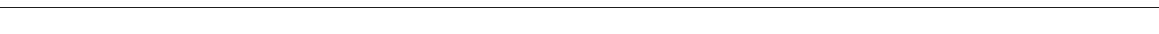
Fig. 5 The role of the Twist1-Prrx1-TNC PFL as a bistable switch was validated using an in vitro fi broblast line, cutaneous wound healing, and patient- derived CAFs. a Twist1 expression was induced in fi broblasts (MRC5) using a doxycycline-mediated induction system, and we examined the impact of the induced Twist1 on the Prrx1 and TNC expression pro fi les using multiplex immunohistochemistry (mIHC). Bimodal distribution of the triple gene expression, such as all positive vs. all negative, was evident after 7 days of induction. The insert images are enlarged picture of stained cells in each staining images. b We examined the Twist1, Prrx1, and TNC expressions during cutaneous wound healing using multiplex immunohistochemistry. The yellow box is a low power view of the mouse wound area. In this yellow box, dashed circle and arrow indicate area of interest (AOI) which is shown as a high power view. c Quantitative analysis of Twist1, Prrx1, and TNC expression in fi broblasts during wound healing. After we made circle-full-thickness cutaneous wounds (diameter of 5 mm) on the dorsal skin of mice, we determined the Twist1, Prrx1, and TNC expression in fi broblasts at multiple time points using mIHC. We noted highly dynamic changes in these three genes ’ expression in fi broblasts. d The plot is generated based on data derived from Fig. 5b. Fibroblasts that were positive for all three genes were restricted to the granulation tissue formation stage of wound healing. e The GFP reporter, under the control of a Twist1 promoter, was stably integrated into the chromosome of two patient-derived CAFs. Then, we sorted CAFs into Twist1-positive and Twist1-negative CAFs, using fl ow cytometry. f Esophageal cancer-derived CAFs (ECAF#8) were sorted into Twist1-positive and Twist1-negative CAFs. Twist1-positive CAFs were speci fi cally positive for Prrx1 and TNC and also exhibited increased colony-forming abilities. g The Twist1-high CAF (ECAF#8) showed resistance to doxorubicin-induced